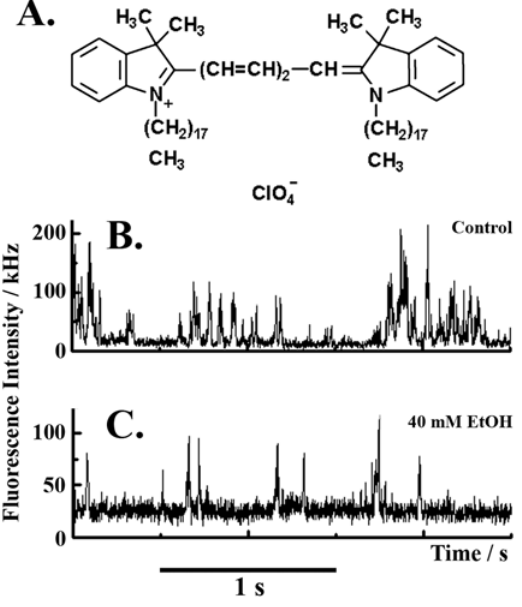
Figure 3. Dynamics of plasma membrane lipids under MOP stimulation with naltrexone and ethanol. A. Structural formula of the general lipid marker 1,1 9 -dioctadecyl-3,3,3 9 ,3 9 -tetramethylindocar- bocyanine perchlorate (DiIC 18 (5)) used as indicator of the plasma membrane lipid dynamics. DiIC 18 (5) was excited using the HeNe 633 nm laser. Fluorescence emitted in the range above 650 nm was collected. B. Fluorescence intensity fluctuations recorded in control cells. The corresponding temporal autocorrelation curve is shown in Fig 5A (black curve). C. Fluorescence intensity fluctuations showing the effect of 40 mM ethanol on the dynamics of plasma membrane lipids recorded after 15 min exposure to ethanol.